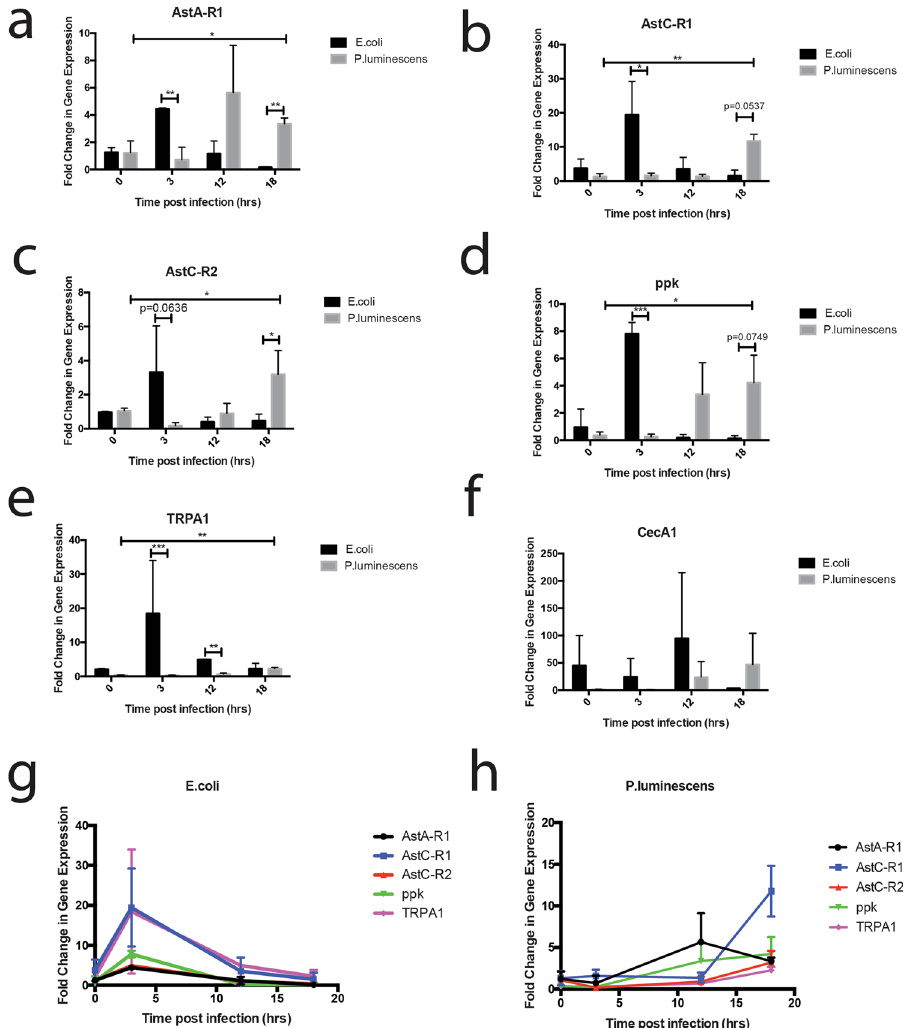
Figure 1. Nociceptive gene expression in Drosophila differs temporally during bacterial infection. Expression of ( a ) AstA-R1 ( b ) AstC-R1 ( c ) AstC-R2 ( d ) ppk ( e ) TRPA1 and ( f ) Cecropin A1 (CecA1) in Oregon flies responding to non-pathogenic E . coli or pathogenic P . luminescens bacteria at 0, 3, 12, and 18 hours post infection. ( g ) Upon infection with E . coli , all pain-related genes are upregulated at 3 hours and their mRNA levels decrease to basal levels by 12 hours. ( h ) Upon P . luminescens infection nociceptive gene transcript levels increase to a peak at either at 12 or 18 hours post infection. Differences in gene expression profiles were analyzed for statistical significance using a student’s t-test (n = 3–4 groups of 10 flies per time point, * p < 0.05, ** p < 0.01, *** p <